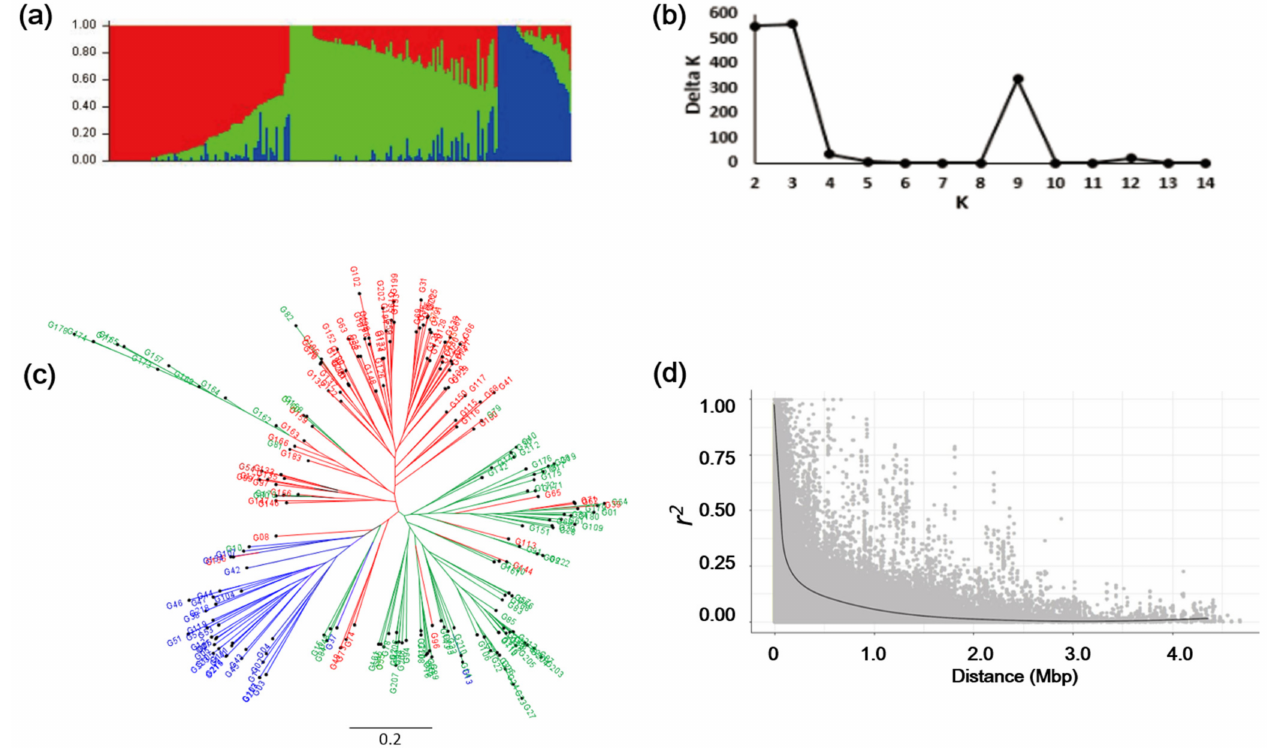
Figure 2. Genetic diversity and population structure.a ( a ) Population structure of 225 radish accessions. One cluster is represented by color ( b ) estimated delta K ranging from 2 to 14. ( c ) Neighbor-joining tree of all 225 radish accessions constructed by SNP markers. ( d ) Estimated linkage disequilibrium decay. Scatter plot showing the linkage disequilibrium (LD) decay across the chromosomes of